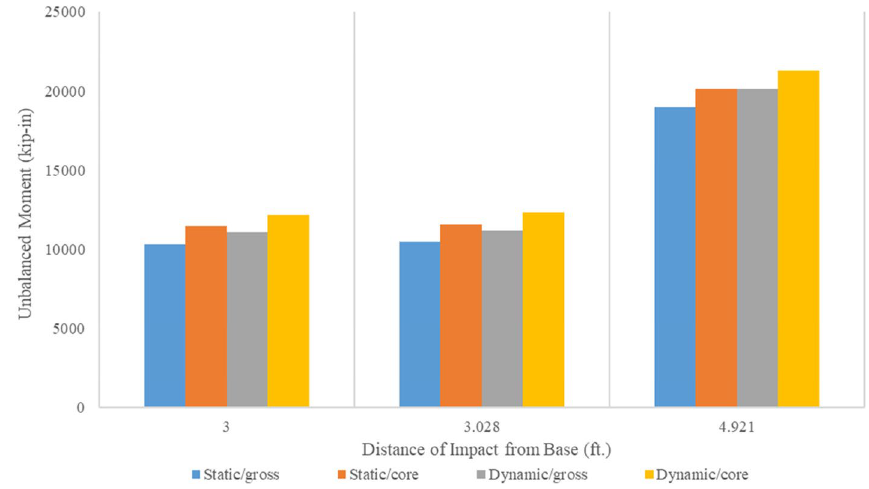
Fig. 5 Unbalanced moments at pier base while impact at different heights in